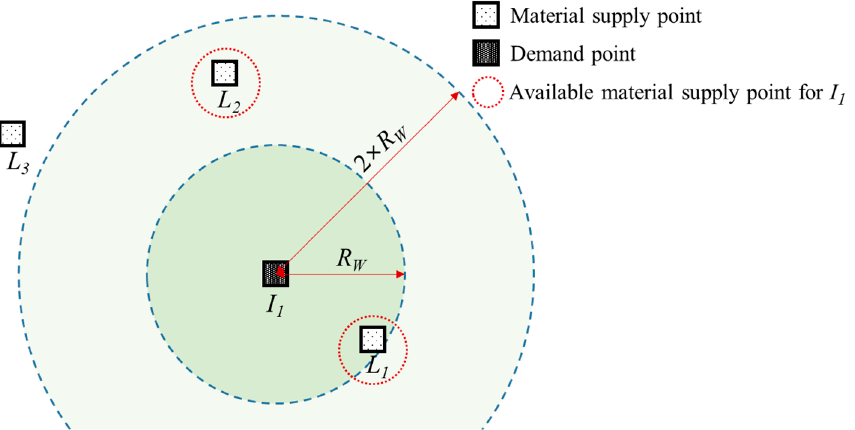
Figure 2. Working range of the mobile crane and the available supply point for the demand point.